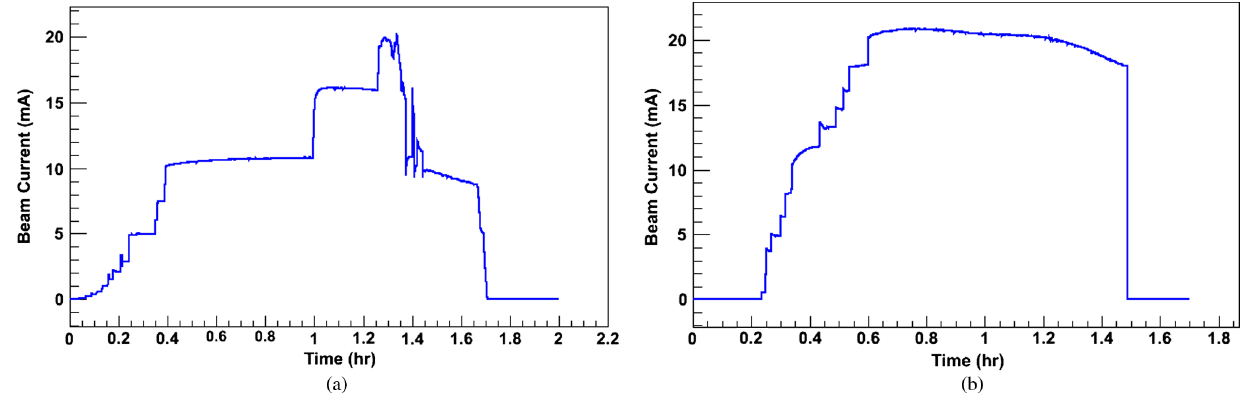
FIG. 10. Beam current versus time using K 2 CsSb photocathode #1 and 532 nm light with laser spot diameter: (a) 500 (cid:1) m FWHM and (b) 1050 (cid:1) m FWHM. The larger laser spot provided longer